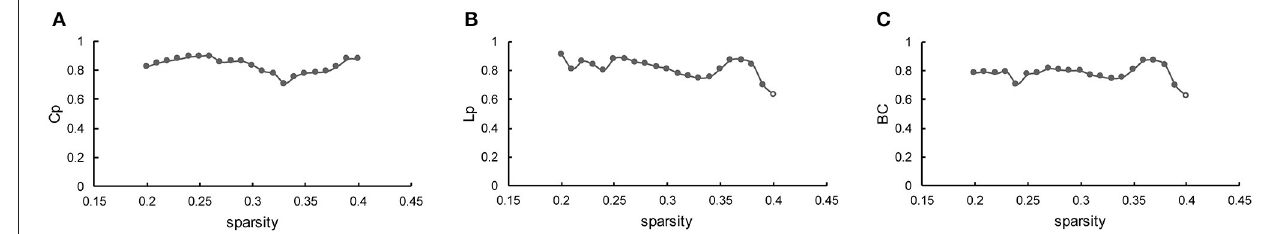
FIGURE 7 | Reproducibility of the method. (A–C) Represents the ICC of C p , L p , and BC as a function of sparsity, respectively. The hollow dot indicates the insignificant result.